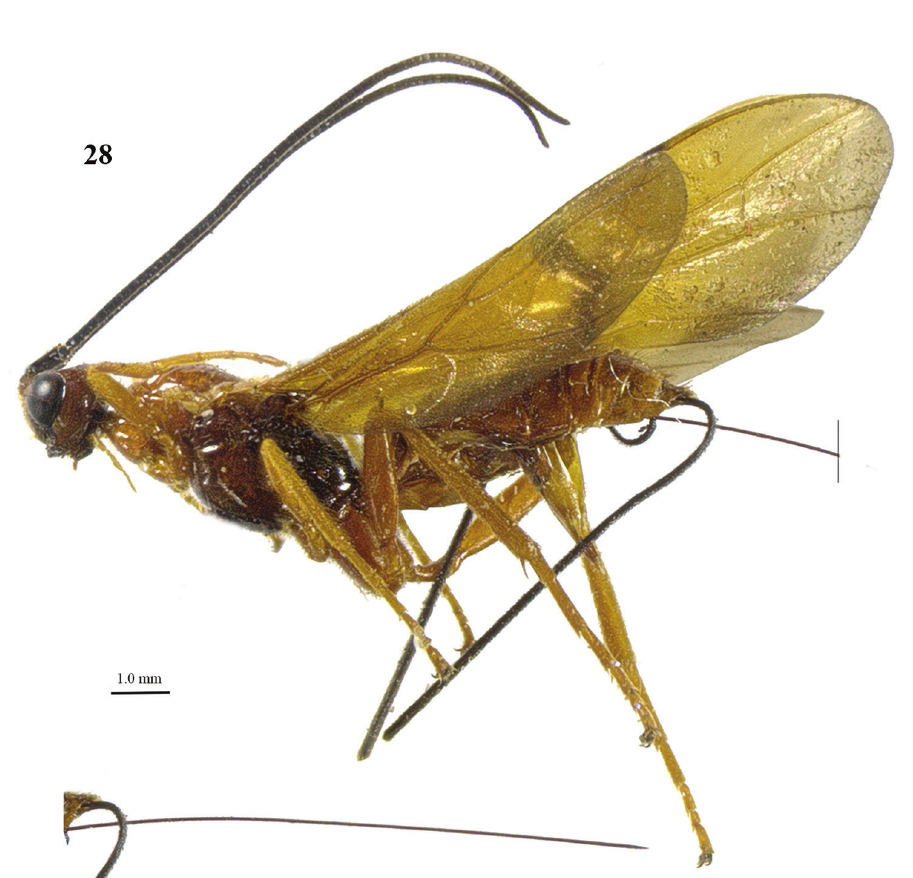
Figure 28. Craspedolcus politus sp. n., ♀ , holotype, habitus lateral. narrowed, its ventral setae erect (Figs 38, 41); third, fourth and penultimate segments 1.8, 1.2 and 1.1 times their maximum width, respectively; length of maxillary palp 0.8 times height of head; eye not emarginated (Fig. 36); face weakly and evenly convex, remotely finely punctate and with long erect yellowish setae; clypeus flat, superficially rugose, dorsally with weak carina and ventral margin thin and lamelliform protruding, with a row of long yellowish setae ventrally; hypoclypeal depression 0.5 times as wide as minimum width of face (Fig. 36); frons shallowly concave behind antennal sock- ets, with deep median groove, smooth except for a few punctures laterally (Fig. 36); vertex smooth except for few punctures and weakly convex, glabrous; OOL:diameter of posterior ocellus:POL = 30:7:5; in dorsal view length of eye 1.4 times temple; tem- ples subparallel-sided behind eyes, with spaced setiferous punctures and long setae (Figs 37, 39); malar suture absent present and curved; length of malar space 0.8 times basal width of mandible; mandible twisted and with two wide